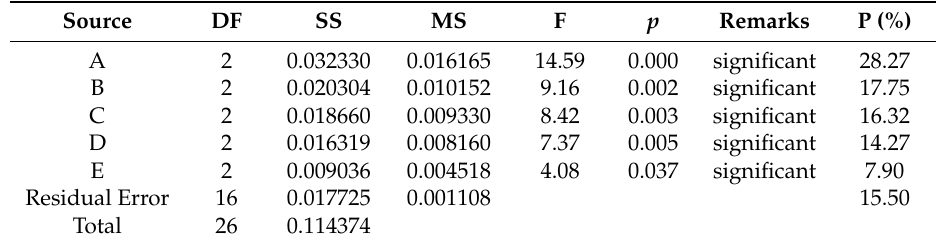
Table 13. ANOVA for the